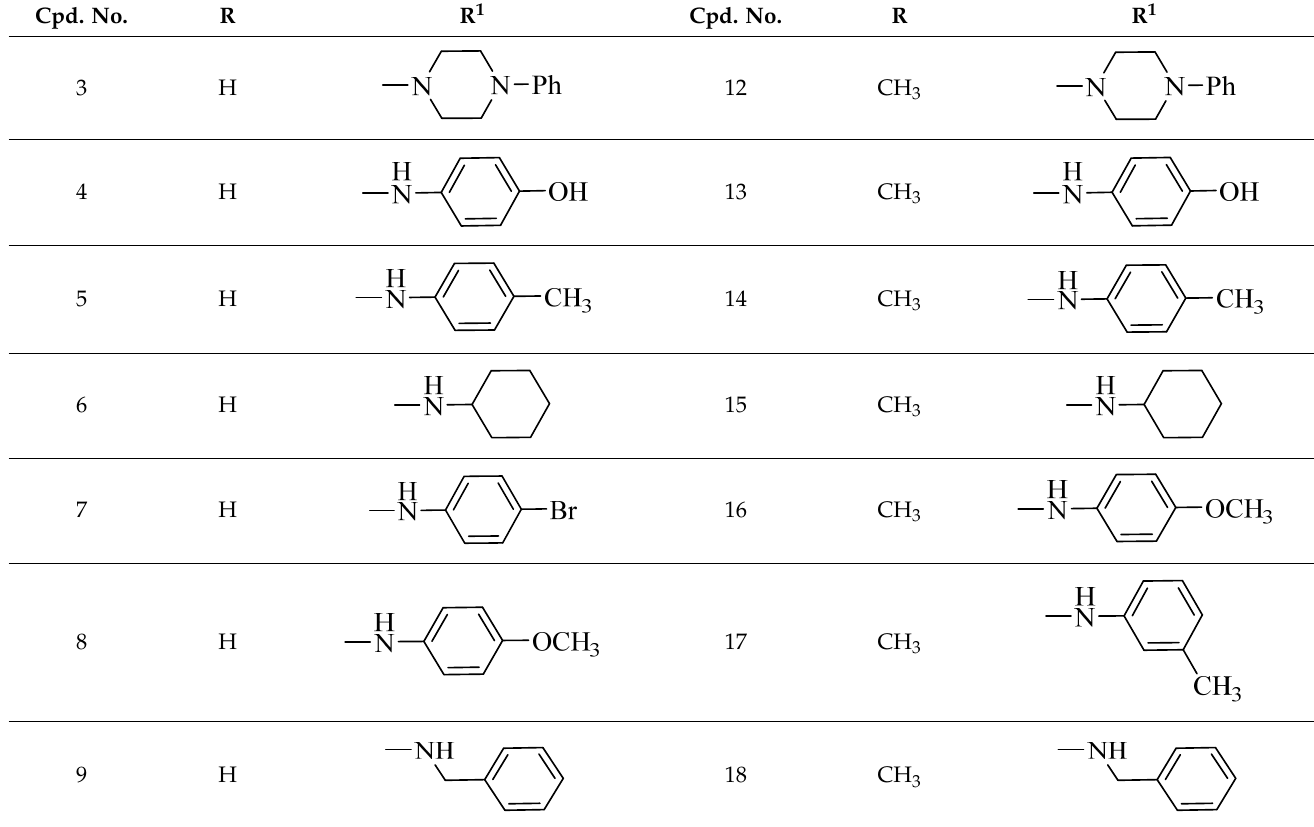
Figure 3. Scheme for the preparation of the candidate compounds. Table 1. Detailed structure of the semi synthesized compounds 3 – 20 . Cpd. No.